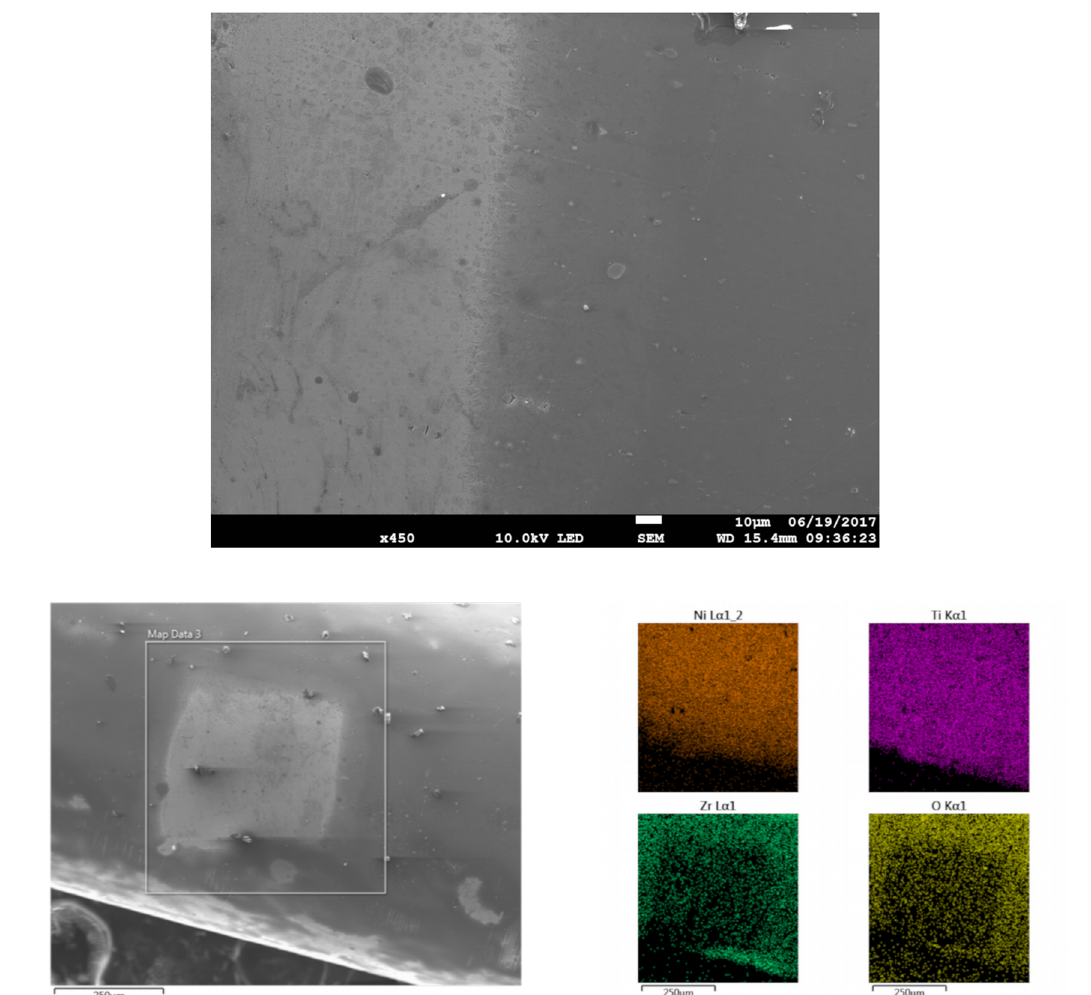
after ToF-SIMS 2